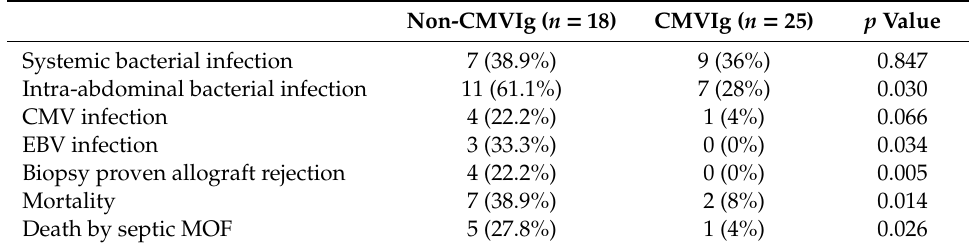
Table 2. Post-LT outcome at 3 months.